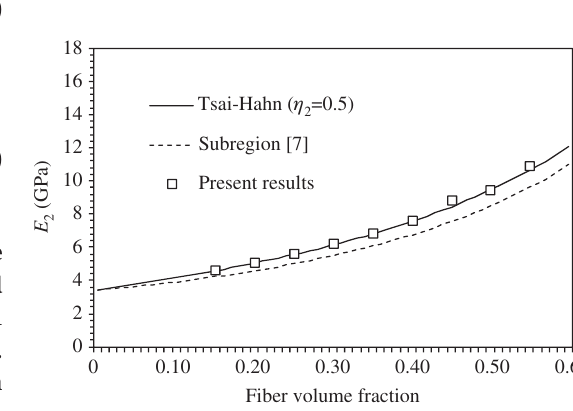
Figure 4 Transverse modulus for e-glass/epoxy.